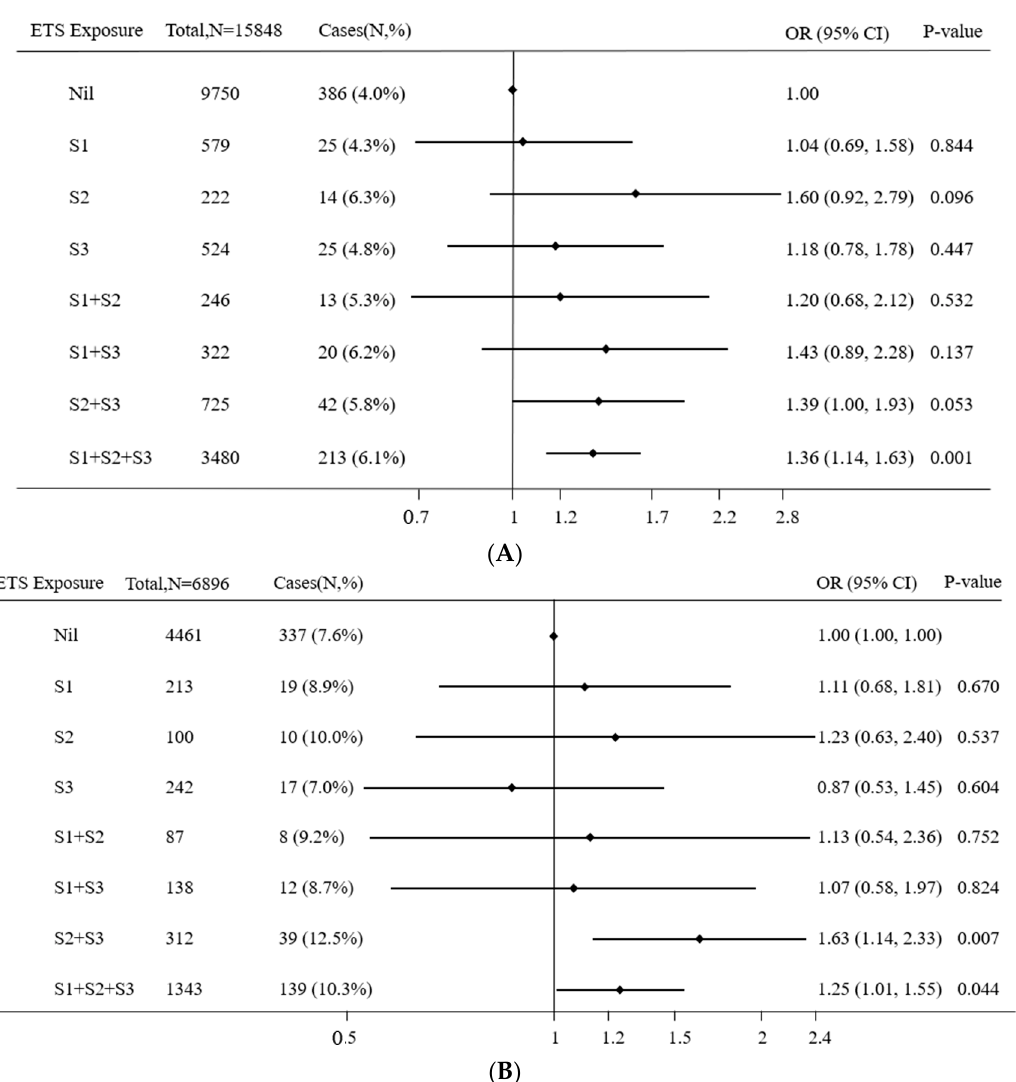
Figure 2. Sensitivity analysis of association between astigmatism and combinations of pre- and post-natal ETS exposure without any parental history of visual problems ( A ) and with parental history of others visual problems except for astigmatism ( B ). ETS: Environmental tobacco smoke, OR: Odds ratios, S1: During pregnancy, S2: From birth to one year, S3: From one to three years. A binary logistic regression model was used, while adjusting for children’s gender and age, parental education level, family monthly income, parental age at childbirth and electronic screen exposure.